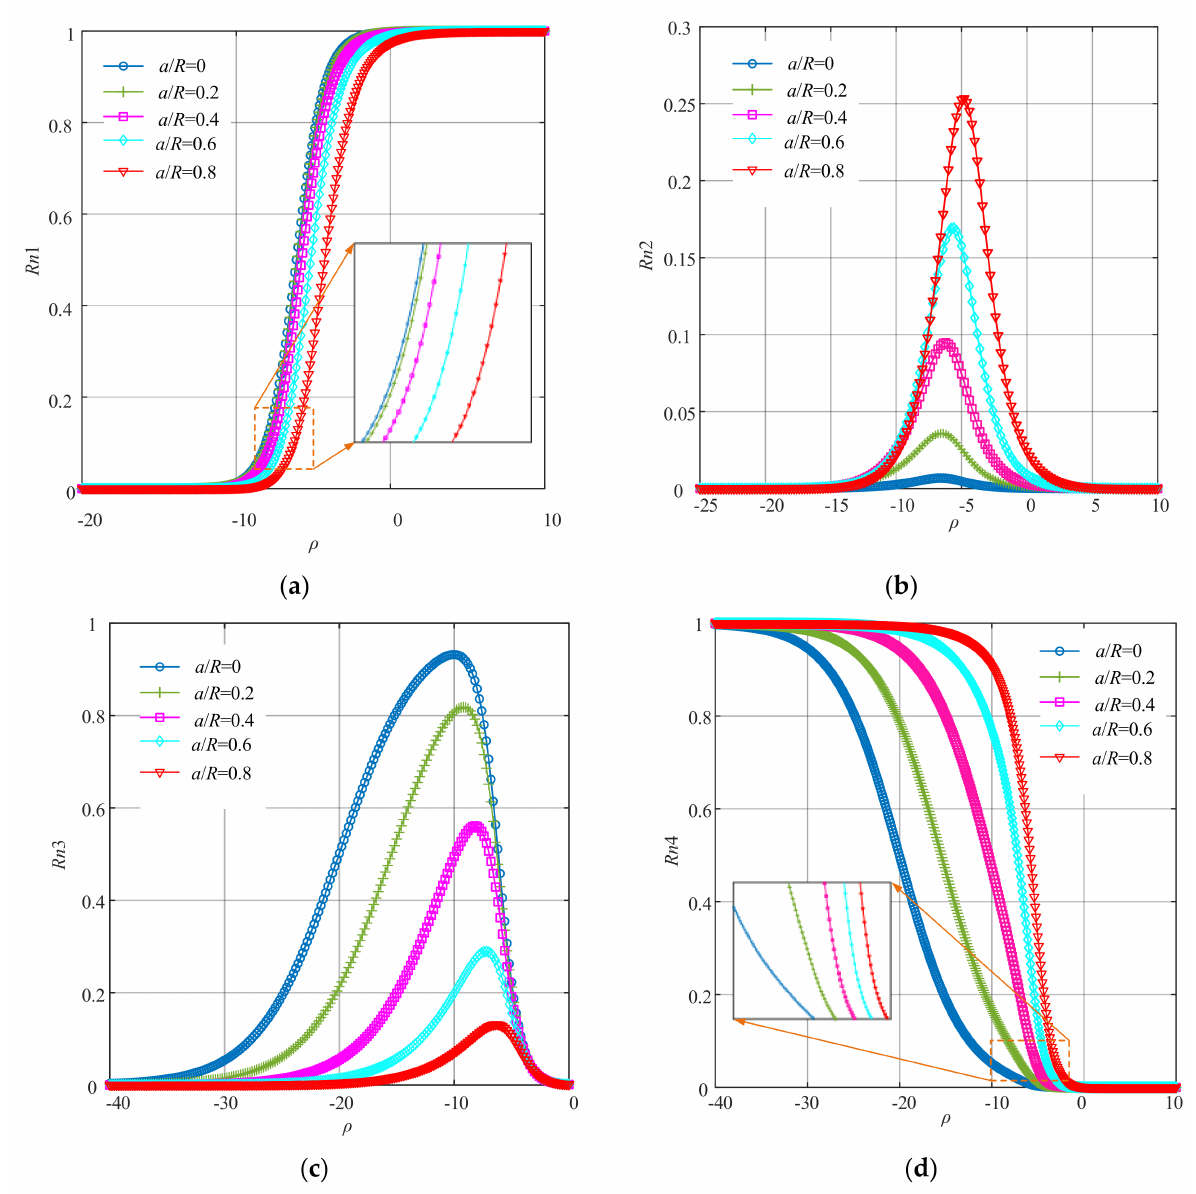
Figure 4. The curves of WNOFRFs under different crack faults: ( a ) Rn 1, ( b ) Rn 2, ( c ) Rn 3 and ( d ) Rn